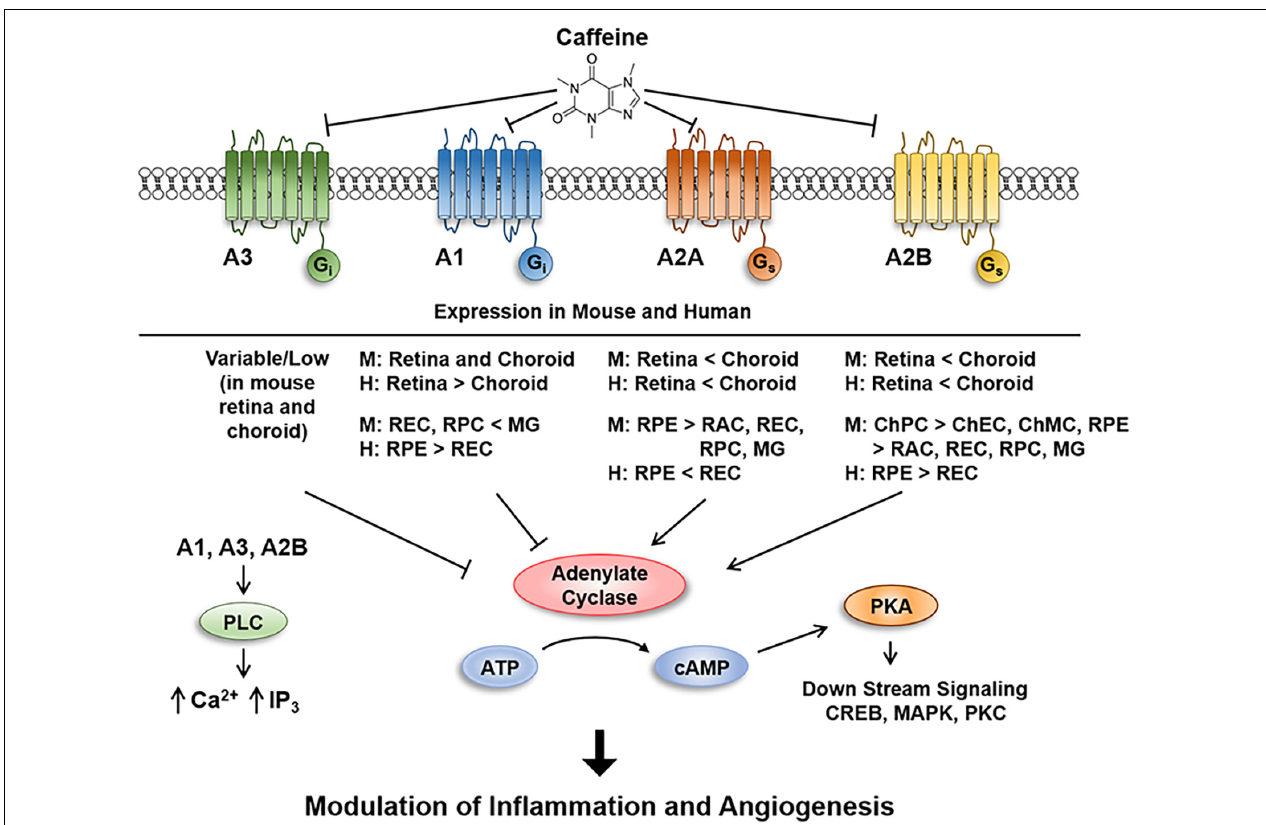
FIGURE 11 | Schematic illustration of caffeine inhibition of signaling through adenosine receptors in retina and choroid. Inhibition of adenosine receptors mitigates sprouting angiogenesis in vitro , ex vivo , and in vivo , in part, by inhibiting the migration of endothelial cells through modulation of pro- and anti-angioinflammatory